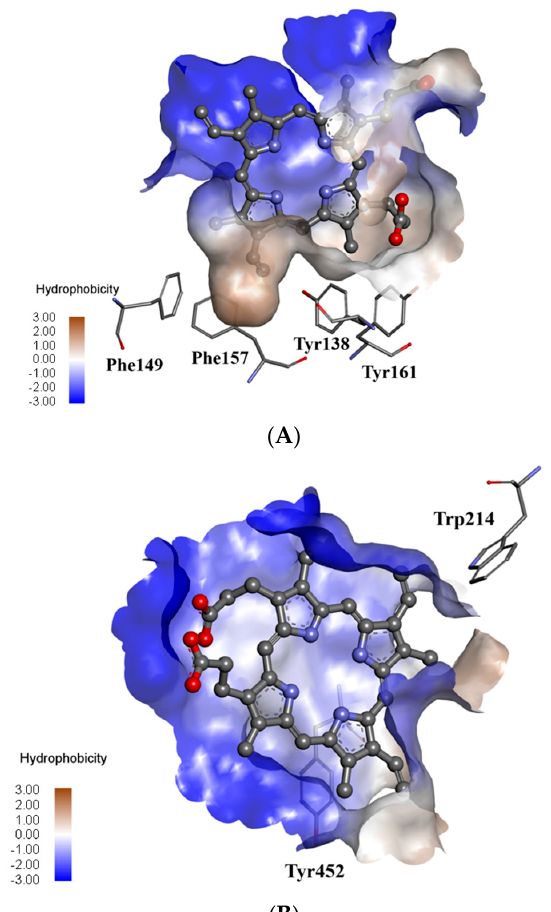
Figure 9. Superposition of the PpIX molecule inside the hemin site ( A ) and Sudlow’s Site 1 ( B ) of the HSA macromolecule. The geometry of the binding sites is colored according to its hydrophobicity. The ligand is shown in the ball and stick representation. Aromatic amino acids are shown in the thin stick representation. For the sake of clarity, only polar hydrogen atoms are displayed.